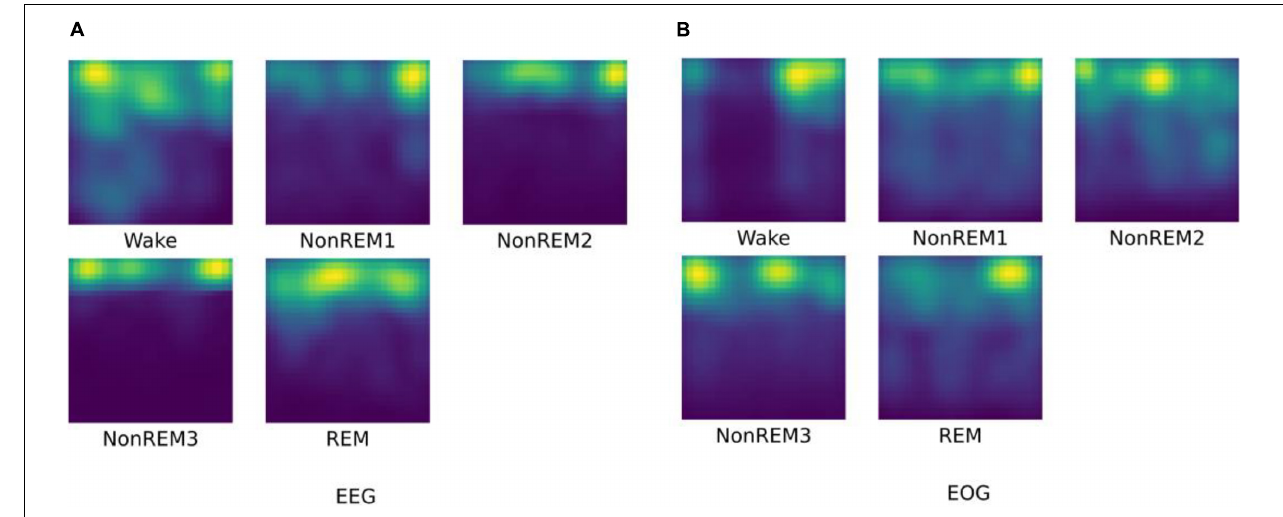
FIGURE 3 | The HHT result for different sleep stages. (A) visualization of EEG HHT results; (B) visualization of EOG HHT results.